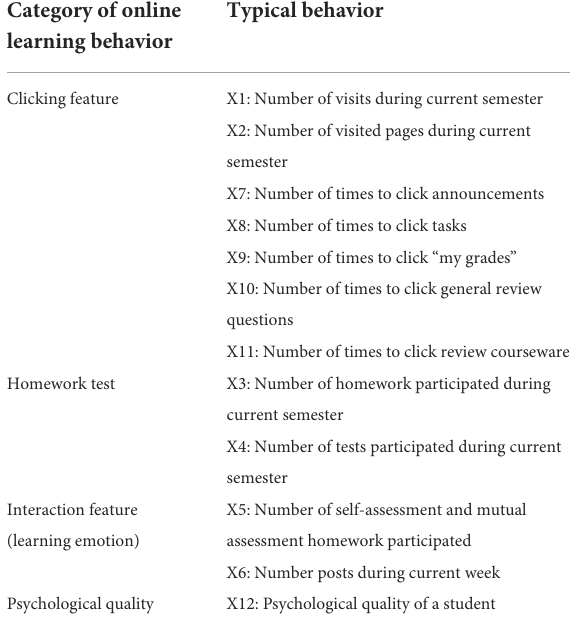
TABLE 1 Factors of learning behaviors. Category of